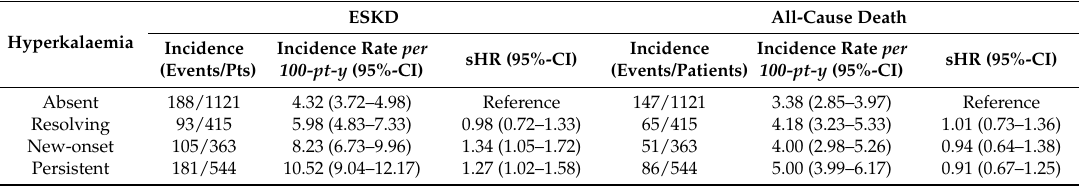
Table 3. Incidence and multi-adjusted risk of ESKD and all-cause death by hyperkalaemia status. Hyperkalaemia